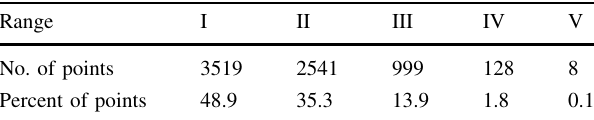
Table 9 Statistics of comparison of the disturbed point cloud with NURBS surface from CC mesh